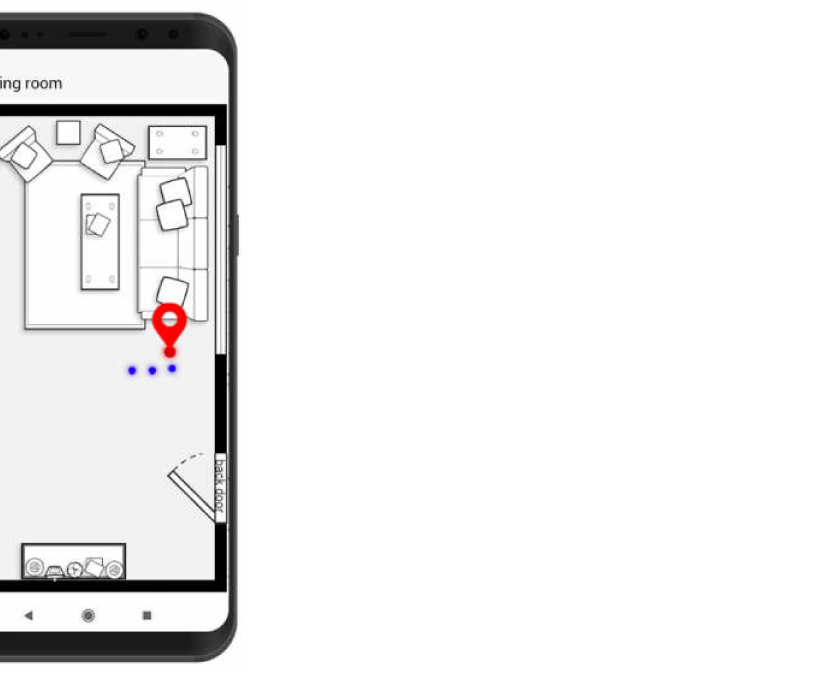
Figure 20. Screenshot of a smart home app prototype using